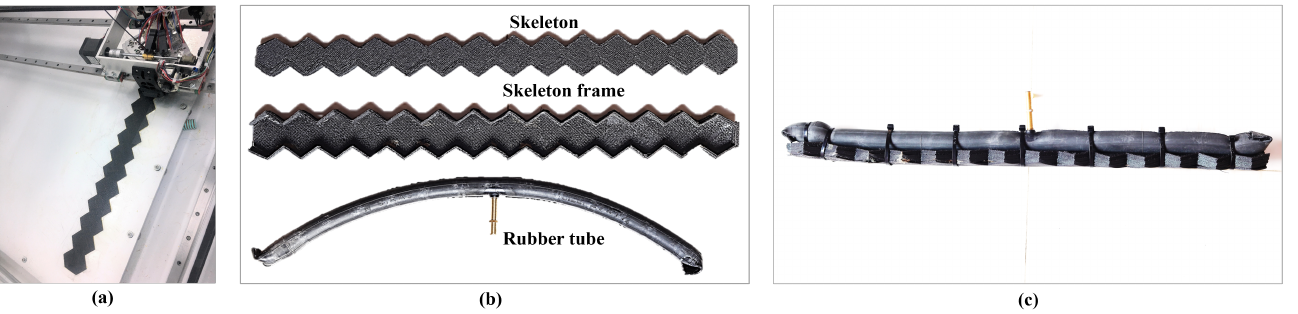
Figure 8. Printed posture corrector ( a ) FDM 3D-printing environment, ( b ) skeleton, its frame and rubber tube, and ( c ) pumped rubber tube placed on the